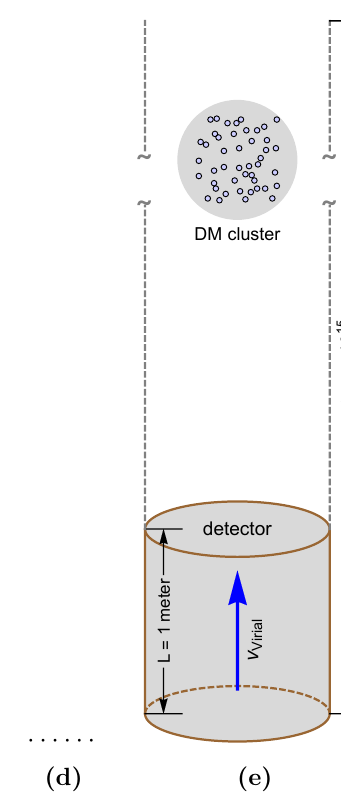
Figure 1 . (a) Unclustered individual DM particles collected by the detector of linear size L = 1 meter. We envision that all DM particles are at rest and only the detector moves up with a relative velocity indicated by the blue arrow of v virial ’ 300 km/sec. In reality the DM particles move as well, but since only their velocity relative to the detector is relevant, this description is